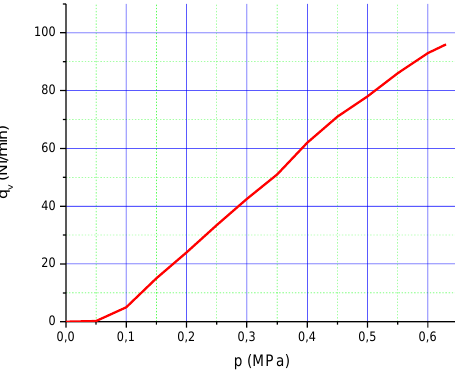
Fig. 9. Characteristic q BGEA-CTA.